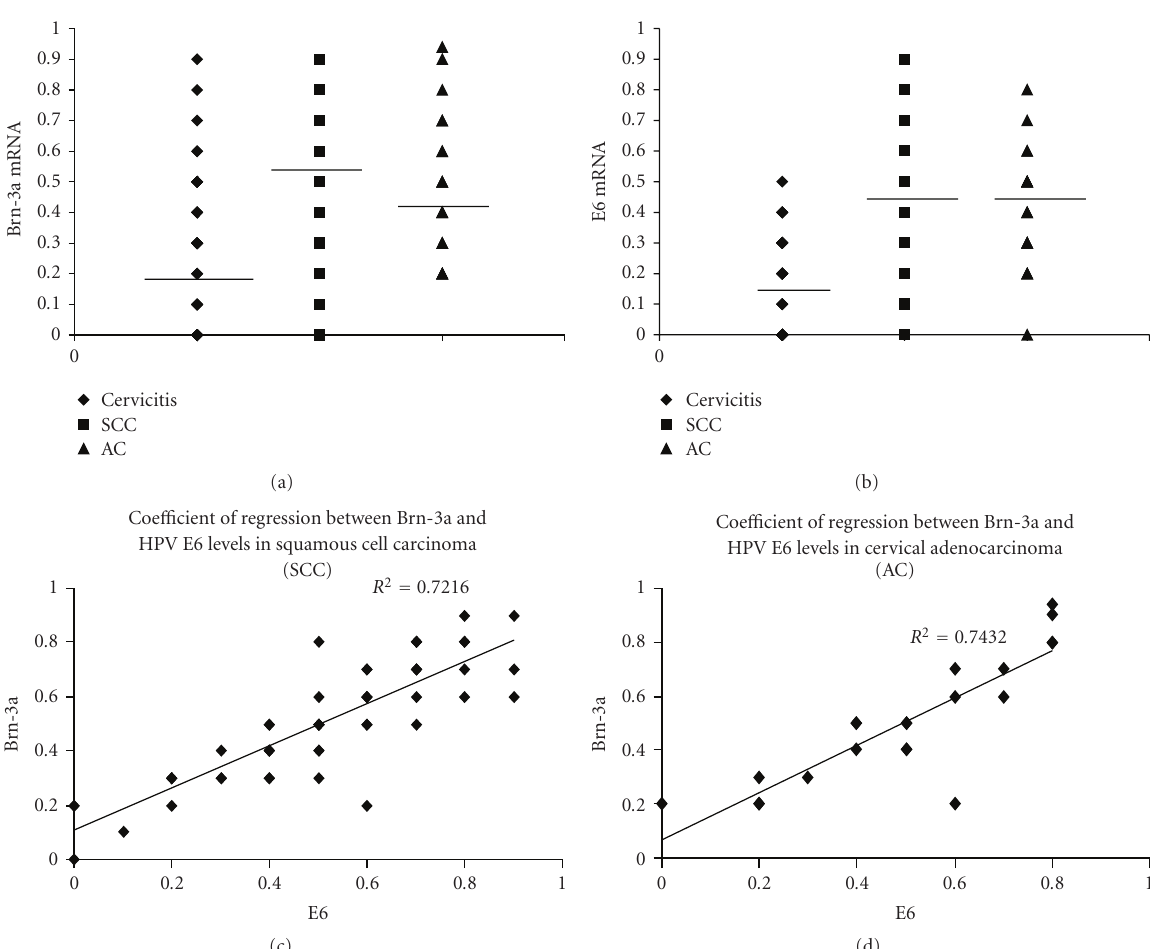
Figure 1: The scatter plot ((a) and (b)) and regression line ((c) and (d)) of Brn-3a and E6 mRNA levels in cervical scrapes obtained from women with High-grade Cervical Intraepithelial Neoplasia (HG CIN) (squamous cell carcinoma (SCC) precancer) and High-grade Cervical Glandular Intraepithelial Neoplasia (HG CGIN) (adenocarcinoma (AC) precancer). Note for the scatter plots, the bar designates the mean Brn-3a and E6 mRNA levels for SCC precancer, AC precancer and cervicitis (as a control group).